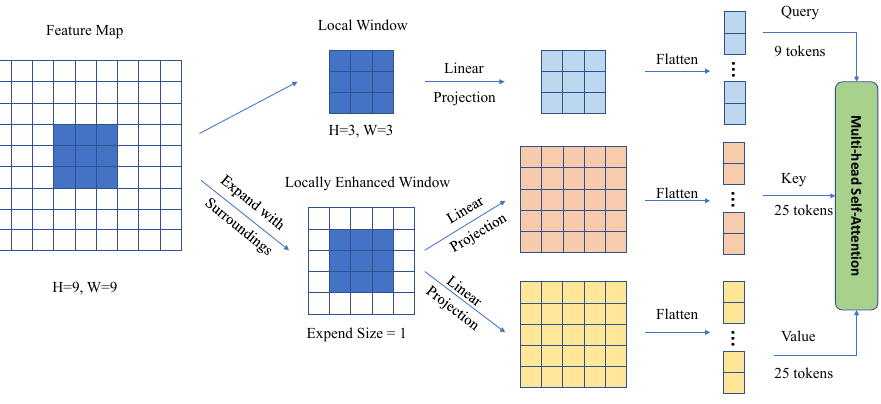
Figure 3. An illustration of the LSA module. For each window, the queries are obtained within each non-overlapping window, while the keys and values are based on the overlapping